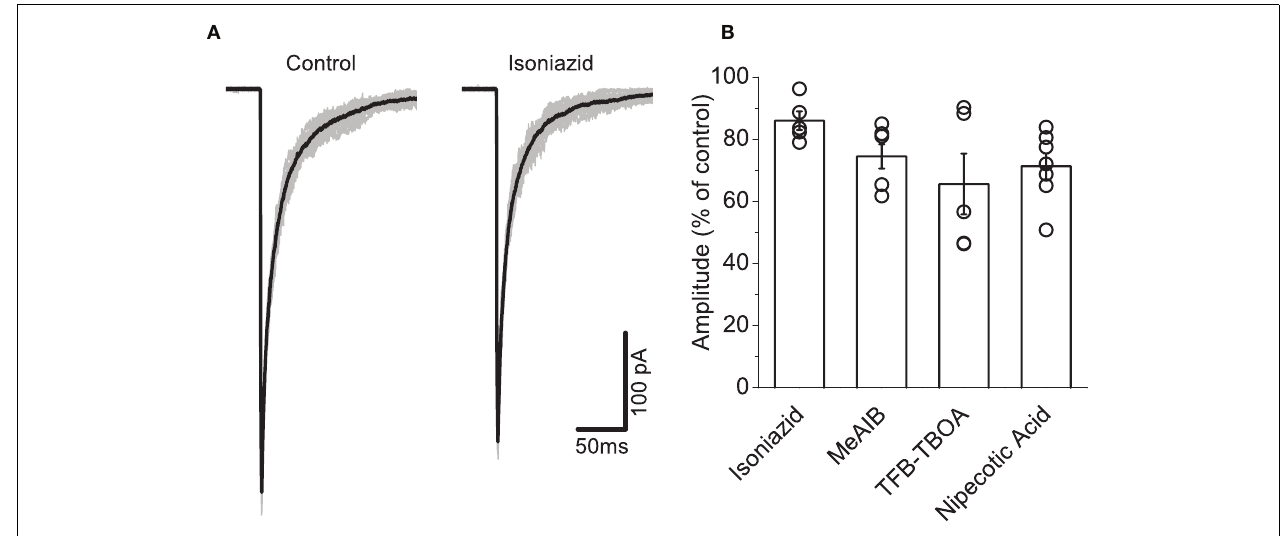
reduction in the current is observed in the presence of 20mM isoniazid. Graph (B) illustrates isoniazid attenuated the current to the least extent